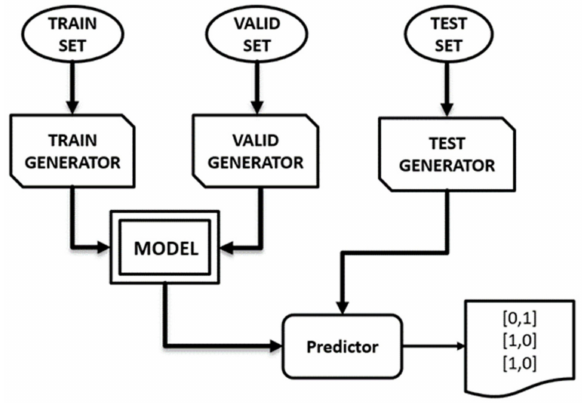
Figure 7. Data flow